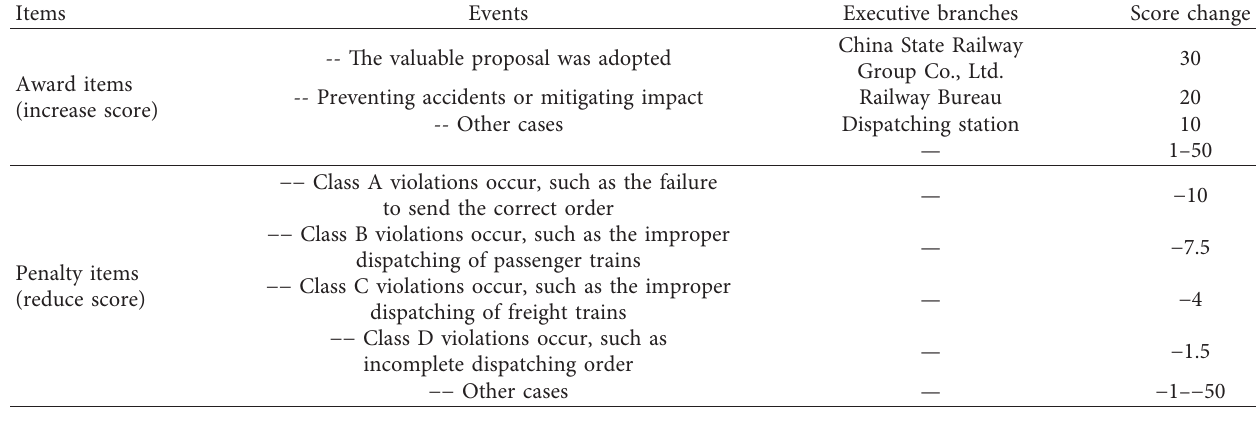
Table 1: The award and penalty scores within HSR dispatcher’s job